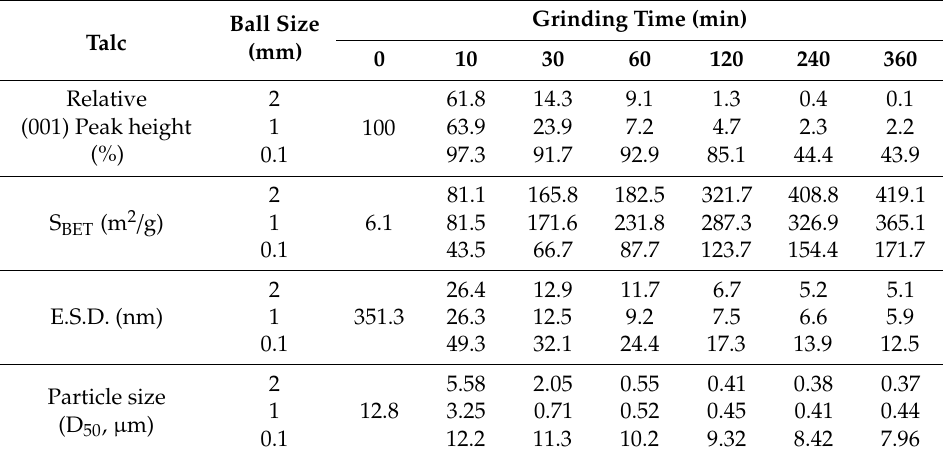
Table 2. Changes in mineralogical parameters as a function of grinding time. Ball Size Talc